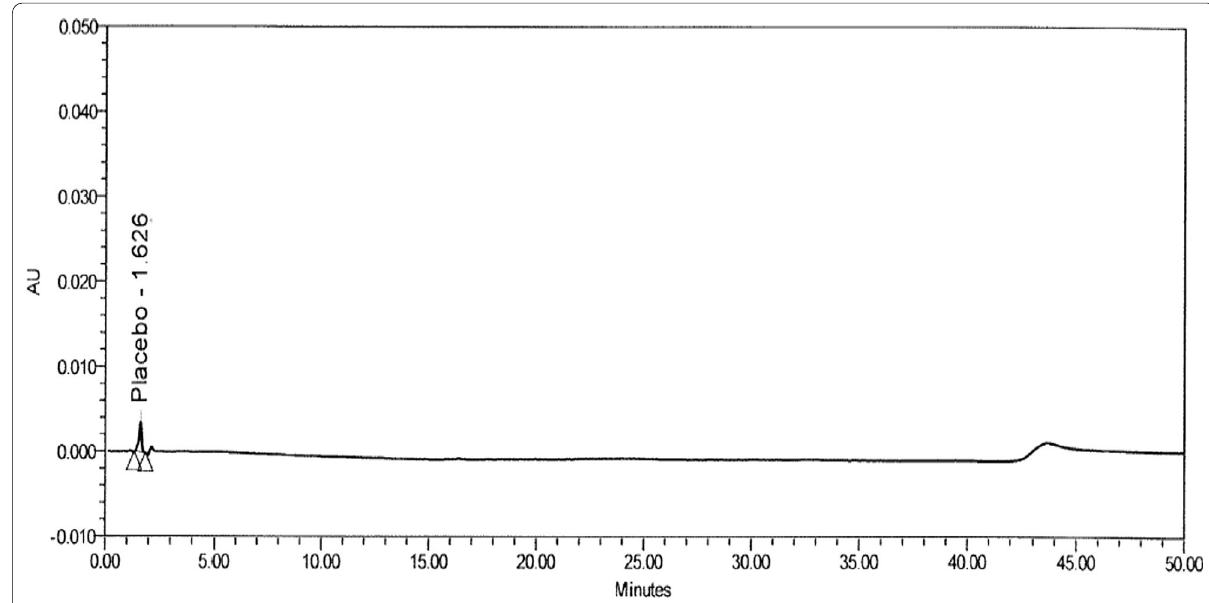
Fig. 9 Typical HPLC chromatogram of placebo solution